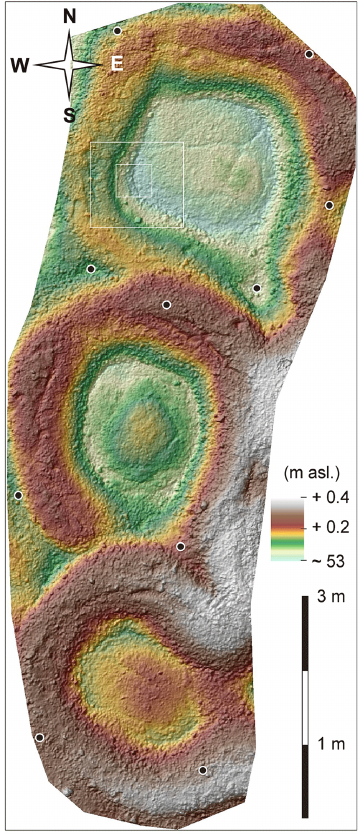
Figure 5. Shaded relief (hillshade) of the 2007 DEM, resampled to 2cm resolution, over the three sorted circles with colour-coded elevation superimposed. Black dots indicate the positions of the ground control points used. The larger rectangle in the south- western part of the northern circle outlines the location shown in Fig. 6, and the smaller rectangle that shown in Fig. 10. Note the soil cracks on the gravel ring tops and on the inner